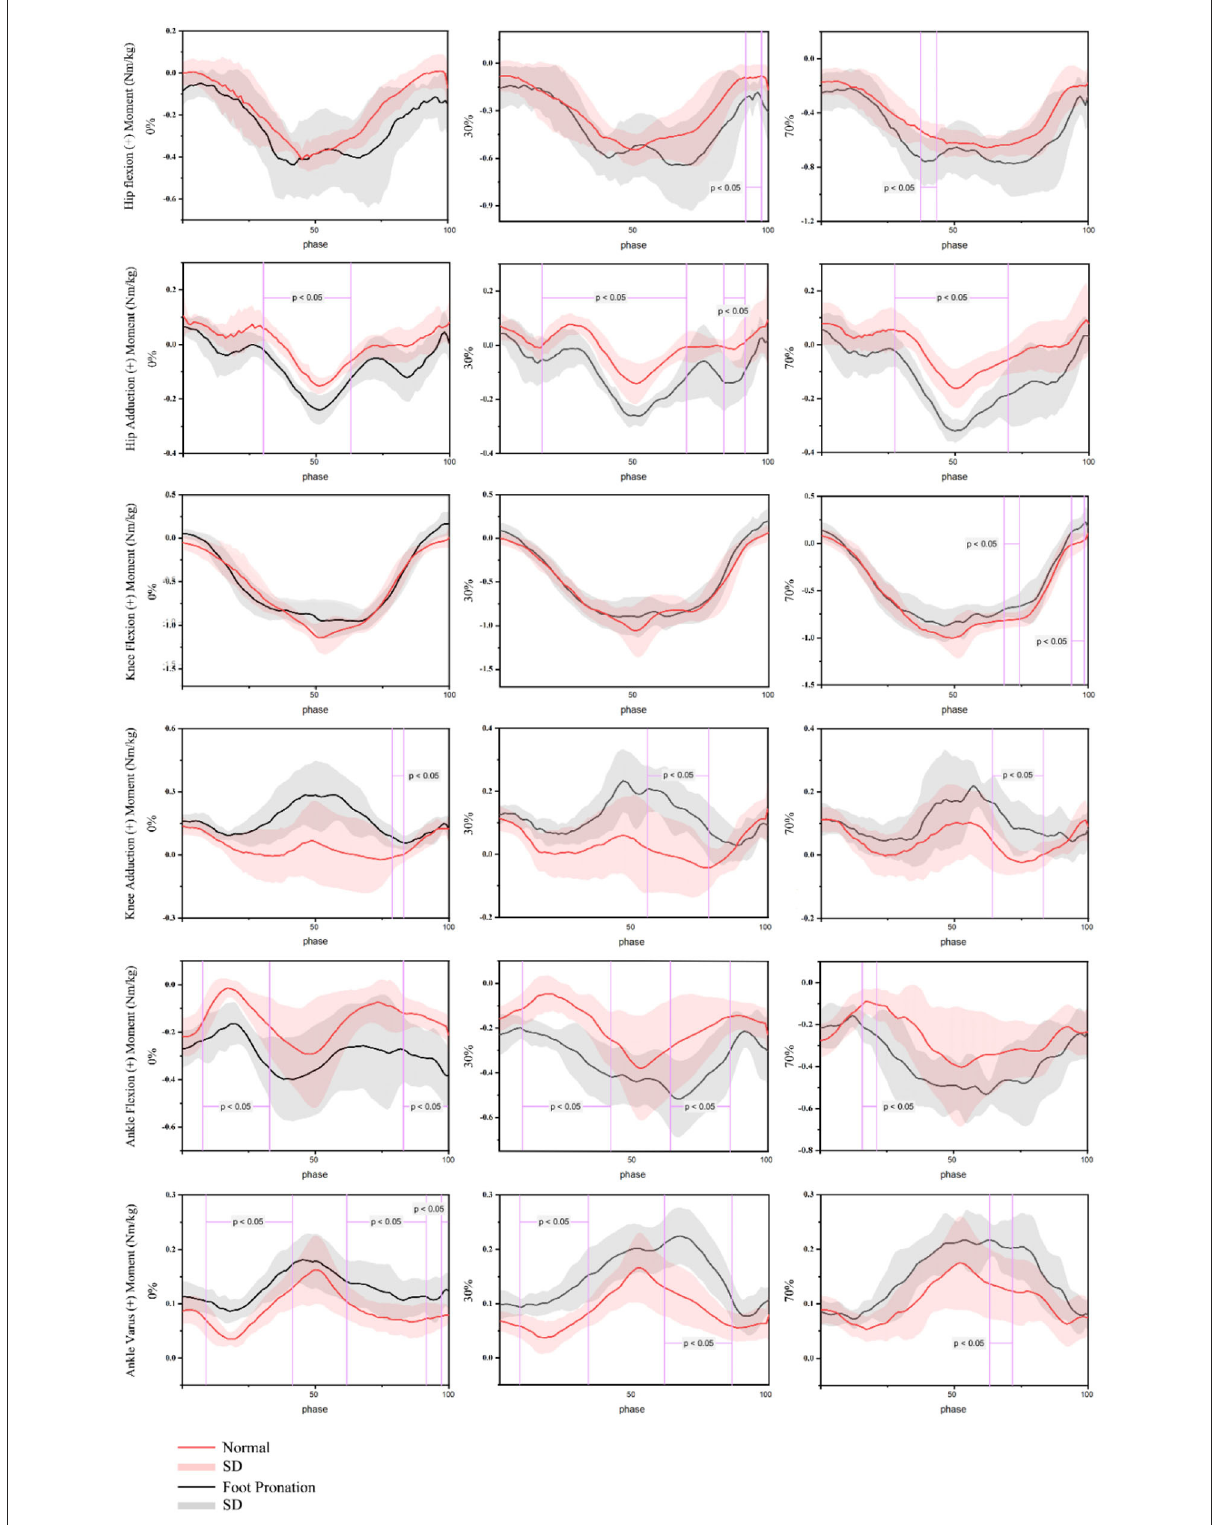
FIGURE5 Joint moment of barbell squatting in people with pronation foot and normal foot